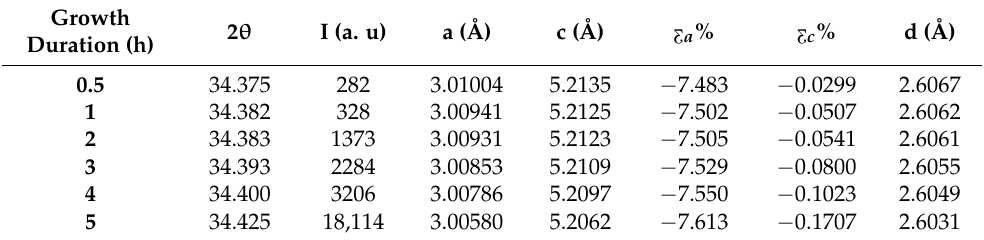
Table 2. Lattice parameters and structure properties of ZnO nanorods of diffraction peak (002) for different growth times where air bubbles